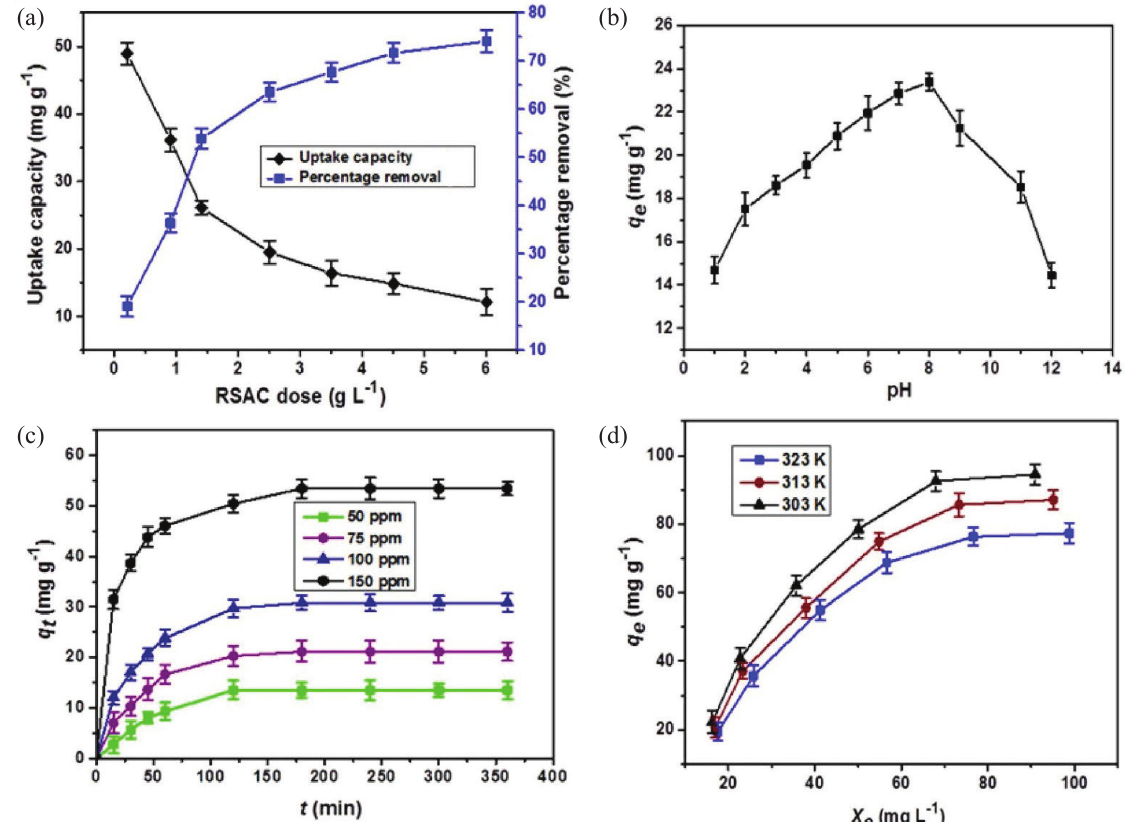
Fig. 5 – Effects of parameters for 2-CP adsorption onto RSAC (a) Effect of RSAC dose, (b) Effect of pH, (c) Effect of initial concentration and contact time, (d) Effect of